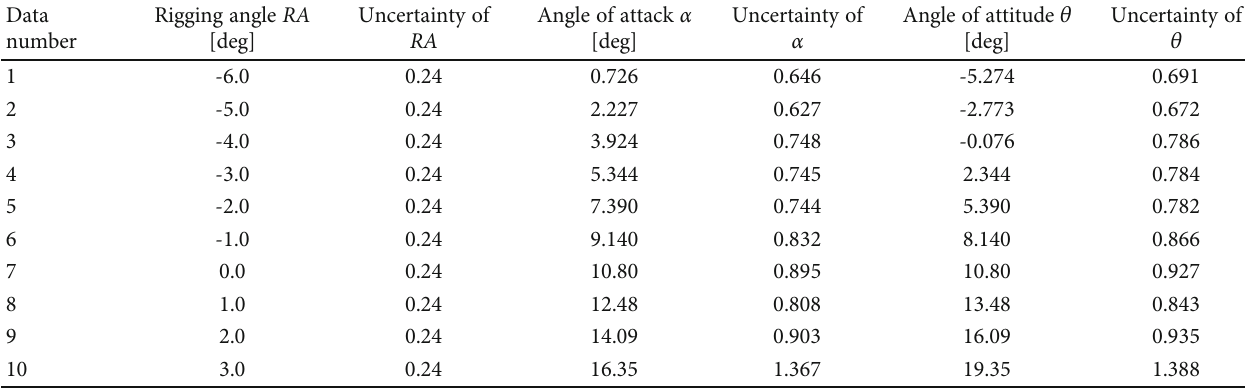
Table 11: Wind tunnel test result of 150Pa wind